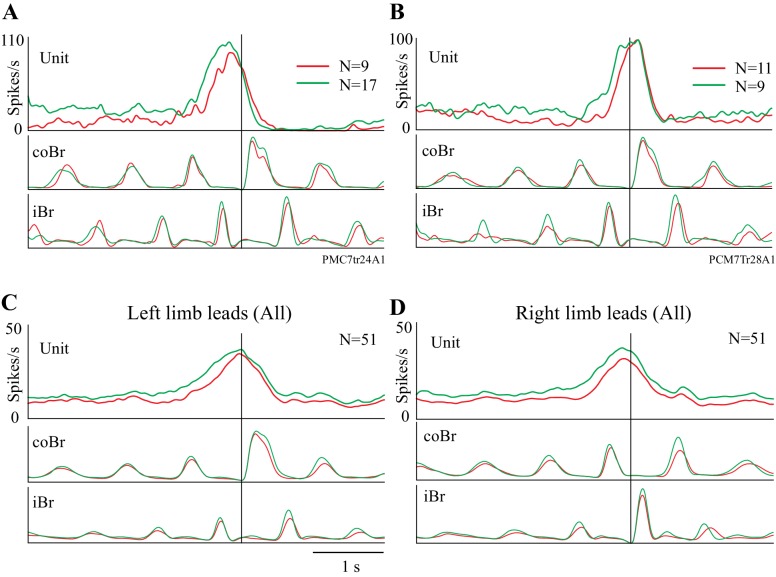
Additional population averages.(A,B) Two examples of distance-related cells during left limb lead condition. Both examples show an earlier onset of activity during the visual dissociation task (green trace) than in the matched task (red trace). Moreover, in both examples, the discharge is also increased for several seconds before the abrupt increase in discharge related to the step over the obstacle, as illustrated in the population averages of Figure 6B,C. (C,D) Population discharge of all 51 cells included in Figure 5, indicating that the ramp discharge of cell activity as the obstacle moves toward the cat is also reflected in the total population of cells that we recorded.